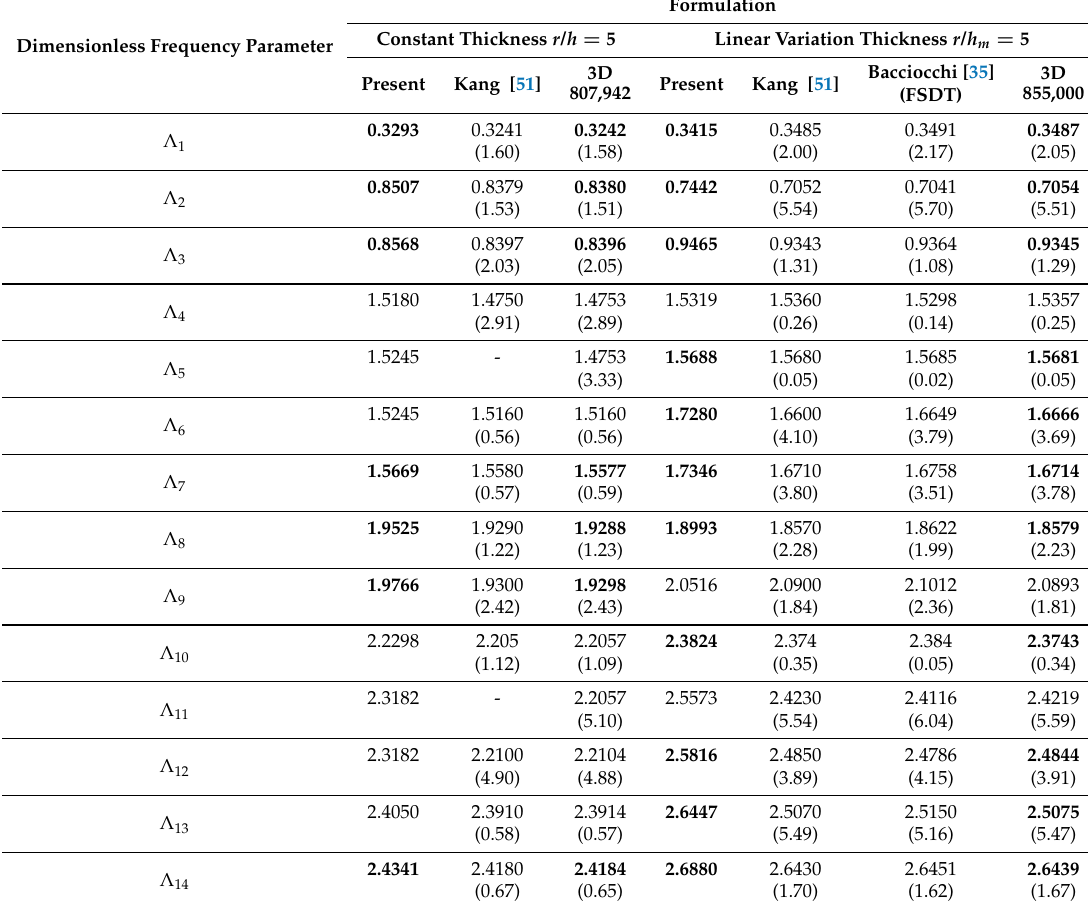
Table 13. Comparison of results for a truncated hemisphere with FF boundary